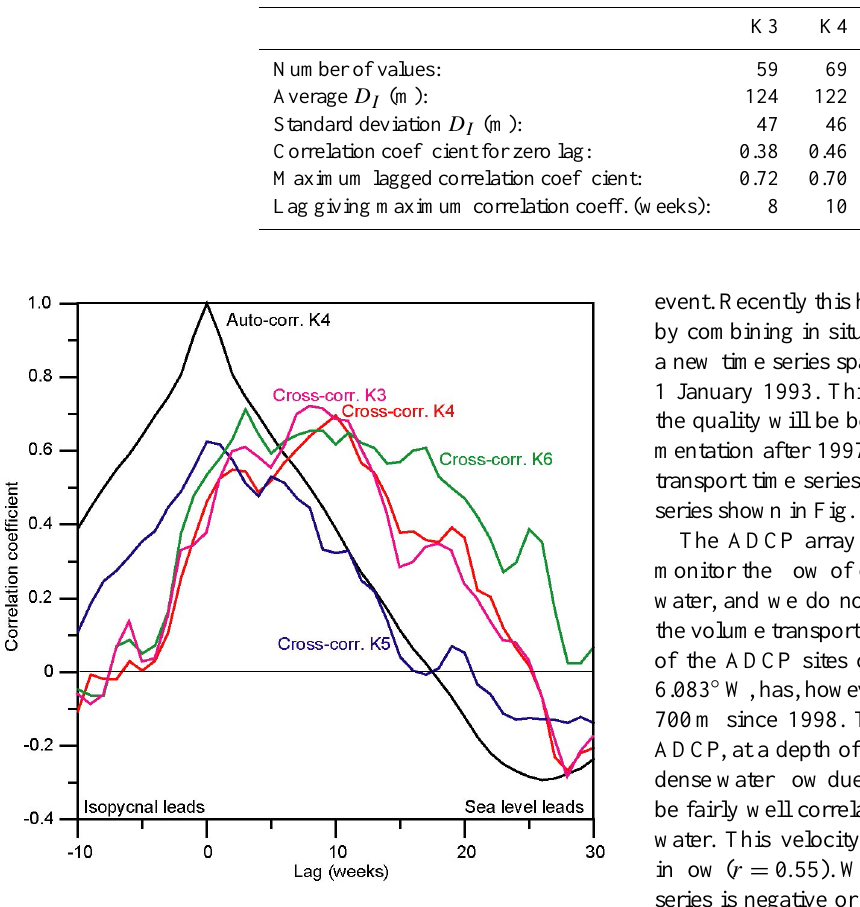
Figure 7. Autocorrelation of the MSLA value at station K4 (black) and lagged cross-correlation between the depth of the interface ( D I ) and associated MSLA value for stations K3 (purple), K4 (red), K5 (blue), and K6